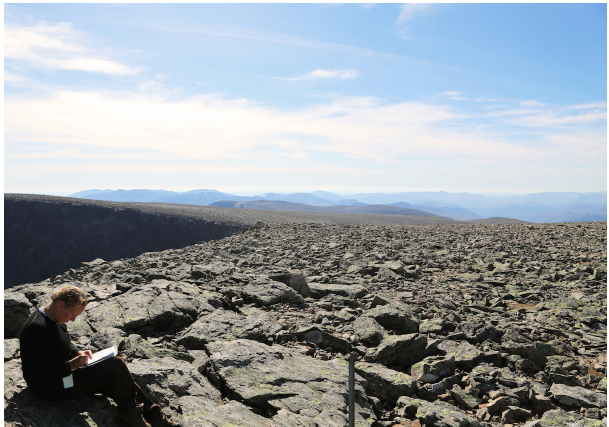
Figure 1. Low-relief summit area at Ranastongi, southern Norway, 1900ma . s . l. Widespread sorting patterns in the debris surrounding the summit suggest periglacial processes are either actively redis- tributing sediment today or have done so in the past. Photo: Chris- tian